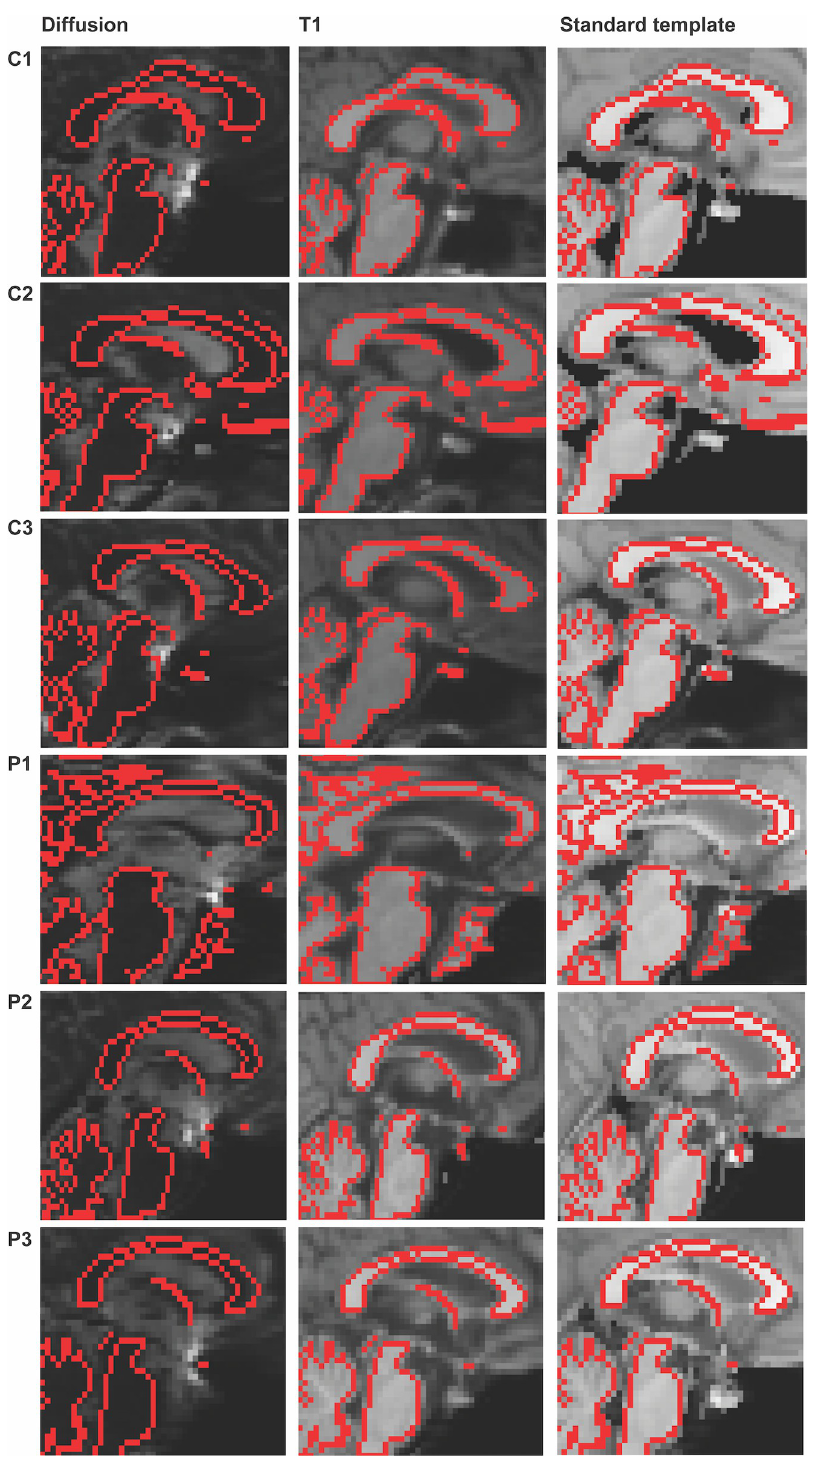
Fig 4. Examples of individual registration performance. Registration of T1 to diffusion image and of standard template to diffusion image on 3 controls (C1, C2, C3) and 3 TBI patients (P1, P2, P3). The mask of the WM boundary (red) resulting from the segmentation of the T1 image in DWI space is used to indicate voxel-wise correspondence among all three images and the accurate structural overlay.